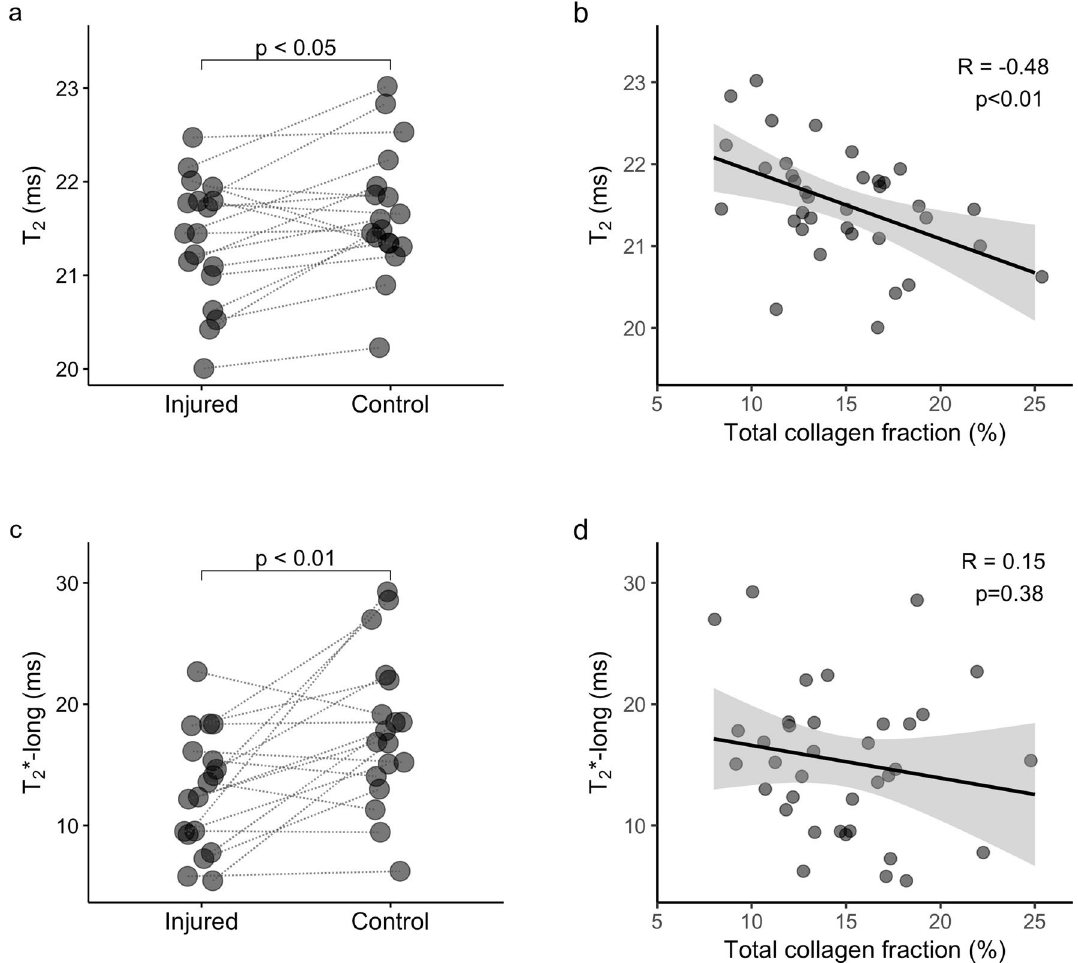
Figure 4. Lower T 2 and long-T 2 * in fibrotic muscle after injury. ( a ) T 2 maps calculated from MSME data revealed shorter T 2 in injured skeletal muscles, which correlated negatively with collagen fraction ( b ). ( c ) T 2 * estimation from UTE signal decay with a bi-exponential off-resonance model showed that water long-T 2 * was also reduced in injured muscles, but it did not correlate with collagen fraction ( d ). Lines connect injured and control muscles for each animal in ( a ) and ( c ). ( b , d ) Scatter plot with fitted linear regression and 95% confidence interval in